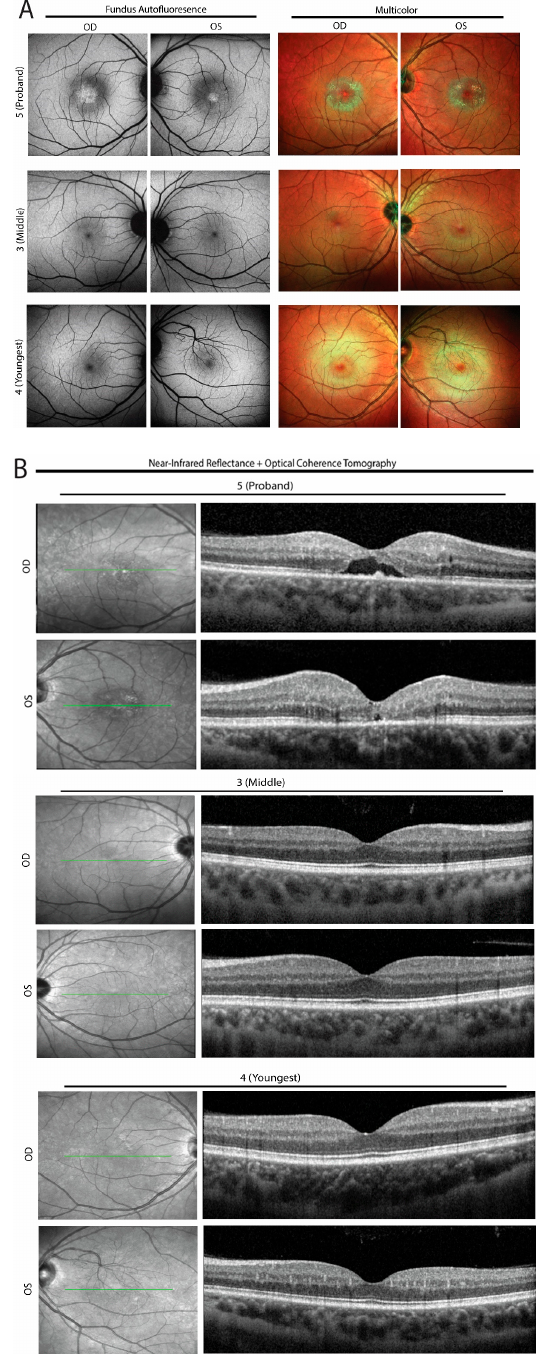
Figure 4. Ophthalmic imaging of the proband and his brothers. Fundus autofluorescence (FAF), multicolor, and optical coherence tomography (OCT) were obtained on the proband and his brothers (individuals 3 and 4). ( A ) FAF of the proband (individual 5, top row) demonstrates abnormal hyper- autofluorescence at the fovea and surrounding parafovea, with corresponding near-circumferential deposition of crystals in the parafovea, as visualized by multicolor imaging. The middle and youngest brothers (middle and bottom rows) were normal on FAF and multicolor imaging, save for an inciden- tally detected congenital macrovessel in the left eye of the youngest brother, a well-described, rare condition not related to HSAN1 or MacTel2. ( B ) OCT imaging of the proband shows outer retinal loss and cavitation as well as some hyperreflective foci, especially in the right eye. OCT imaging of the brothers (middle and bottom rows) were normal. OD = right eye, OS = left